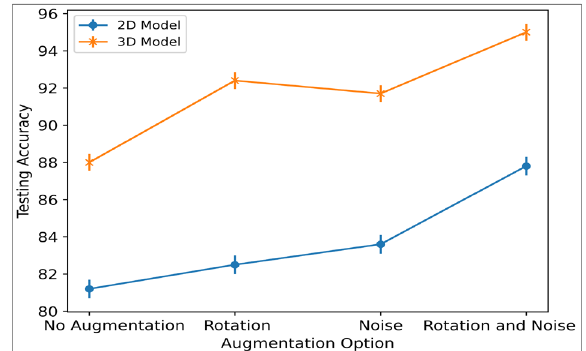
Figure 5. Classification accuracy of different data augmentation strategies for the 3D and 2D deep learning models.